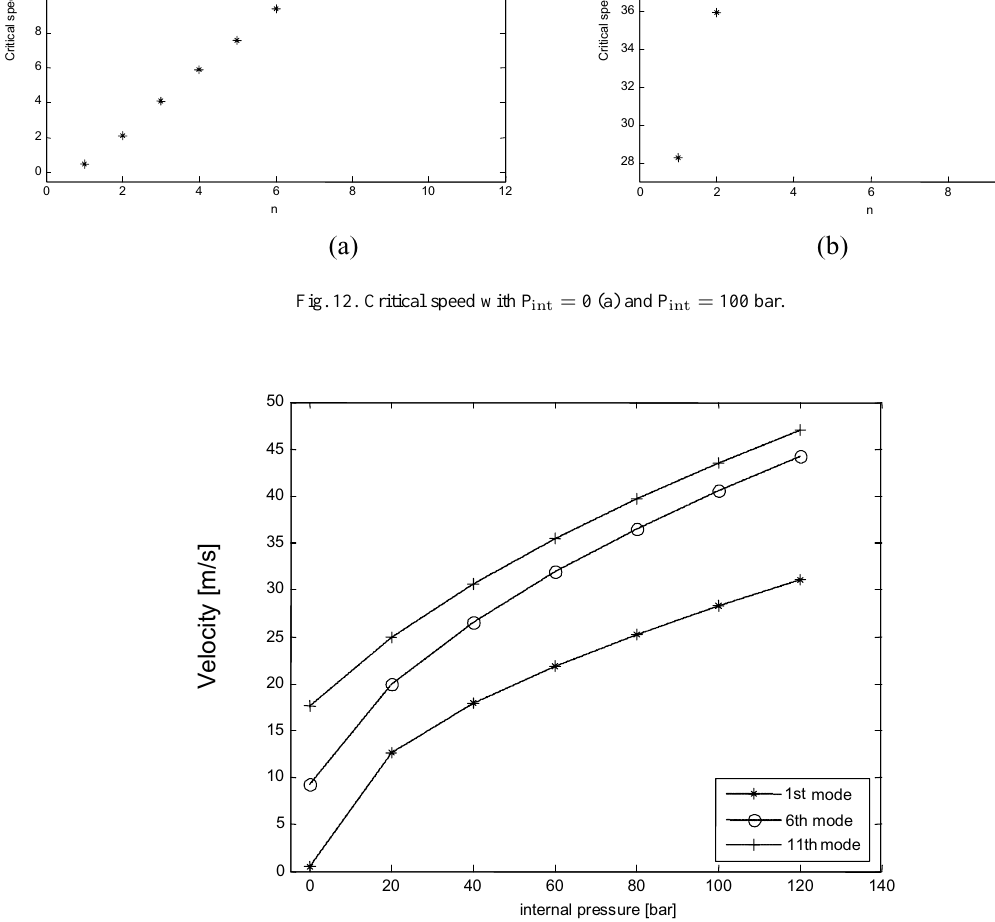
Fig. 13. Influence of pressure on the natural frequencies of modes 1, 6, and